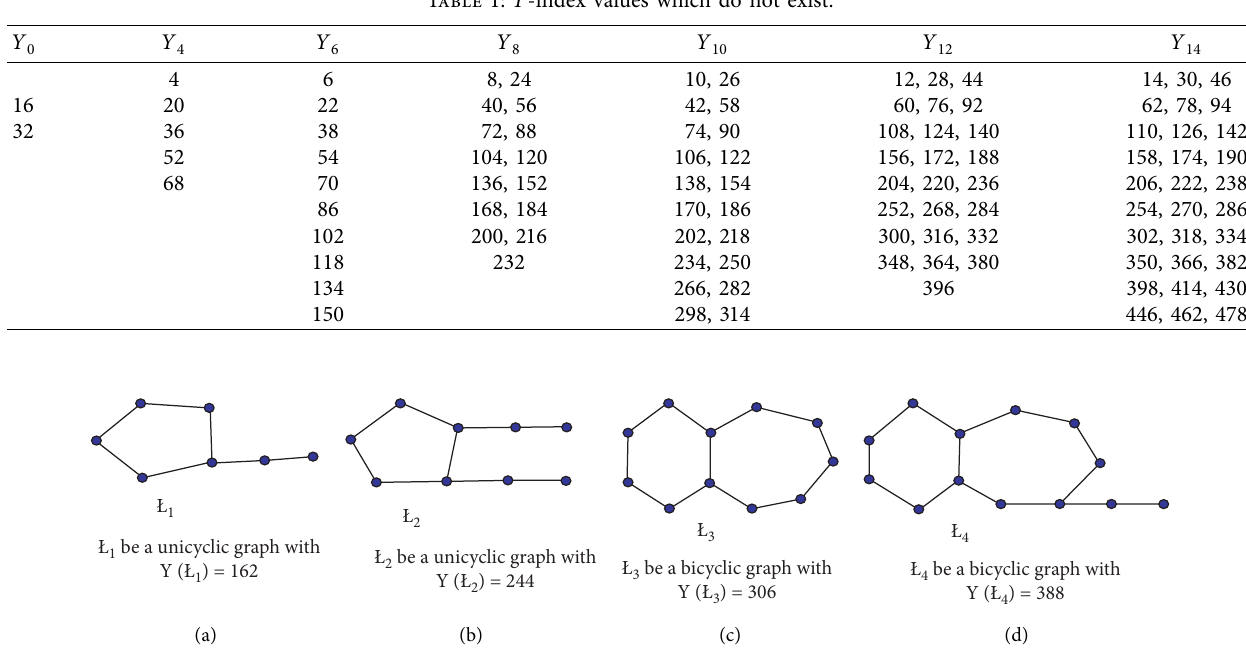
, Ł , Ł , and Ł with Y -index values: (a) let Ł 1 2 3 4 be a bicyclic graph with Y ( Ł 3